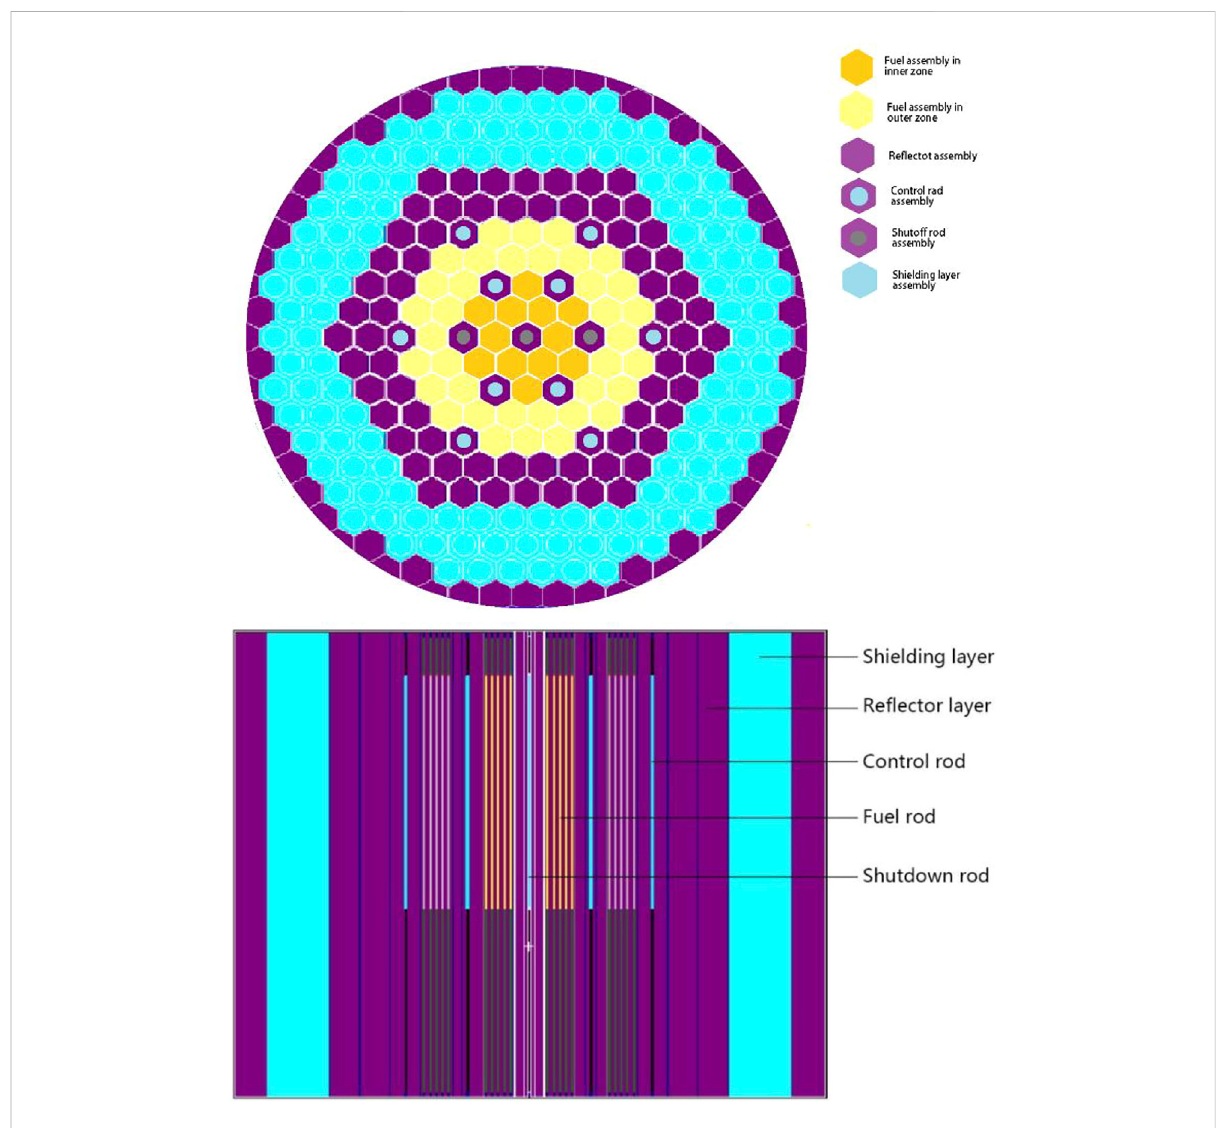
FIGURE 1 Cross-sections of the SPALLER-100